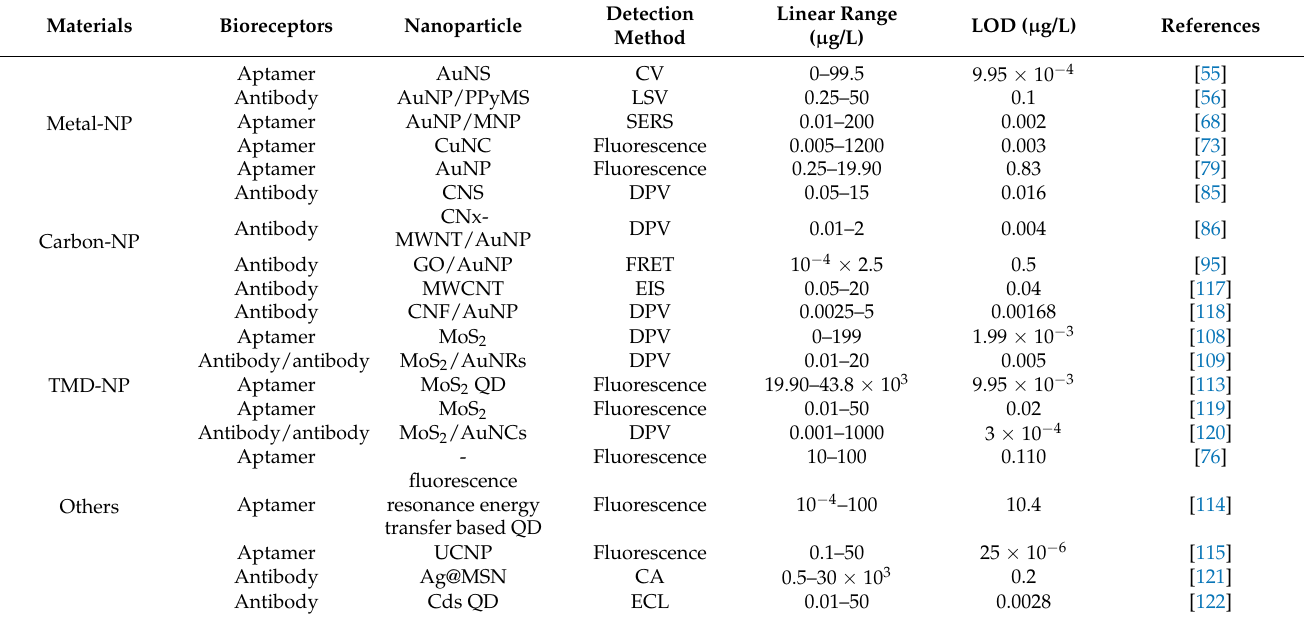
Table 1. MC biosensors composed of various nanomaterials and bioreceptors.